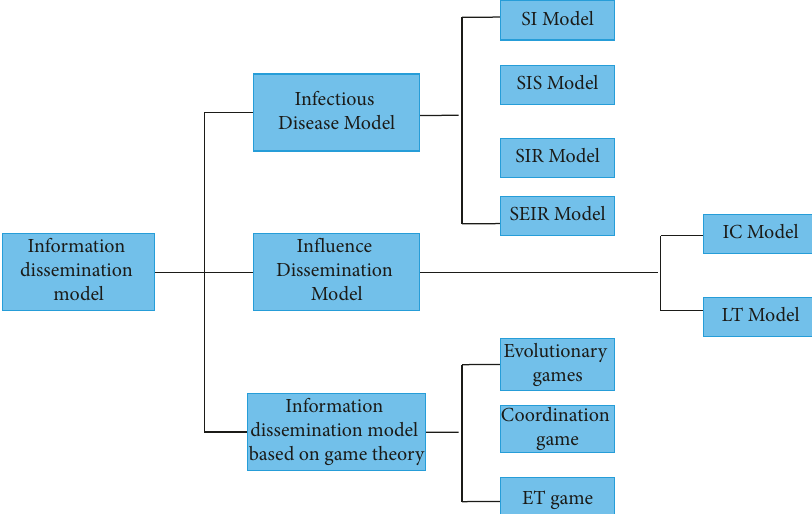
Figure 3: Classification of information propagation